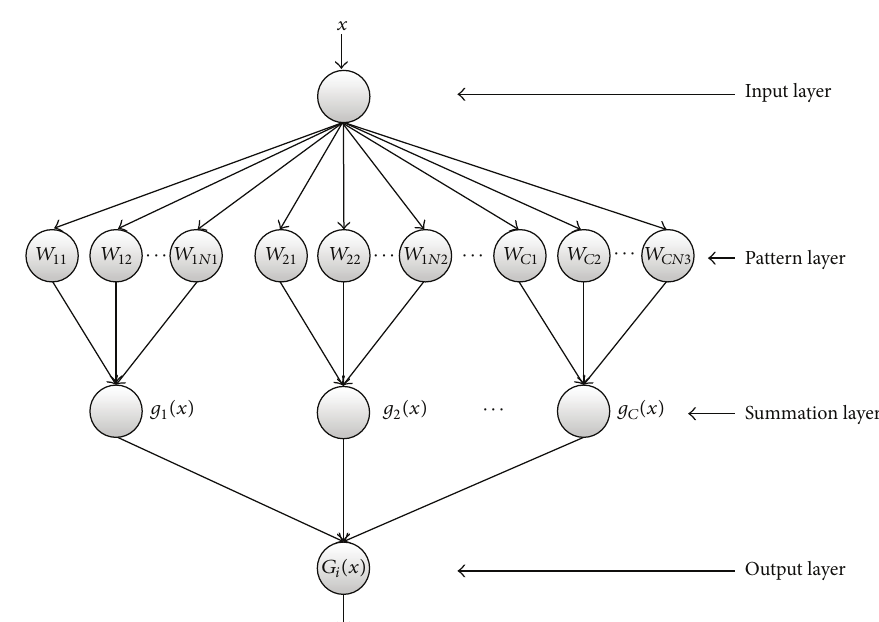
Figure 1: Probabilistic neural network architecture.